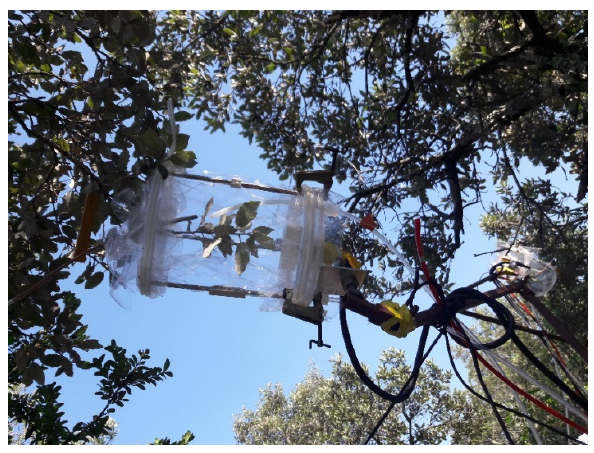
Figure 2. Photo of the branch chamber used during the Puechabon field experiment.